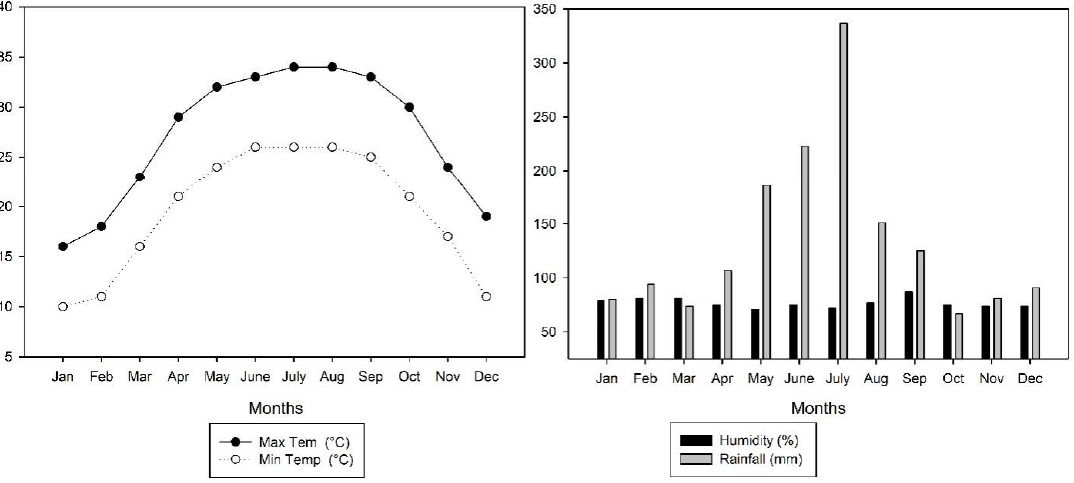
Figure 1. Mean maximum and minimum temperature, relative humidity, and total rainfall during the early and late seasons in 2020. the early and late seasons in Table 1. Rate and timing of biochar and urea application.